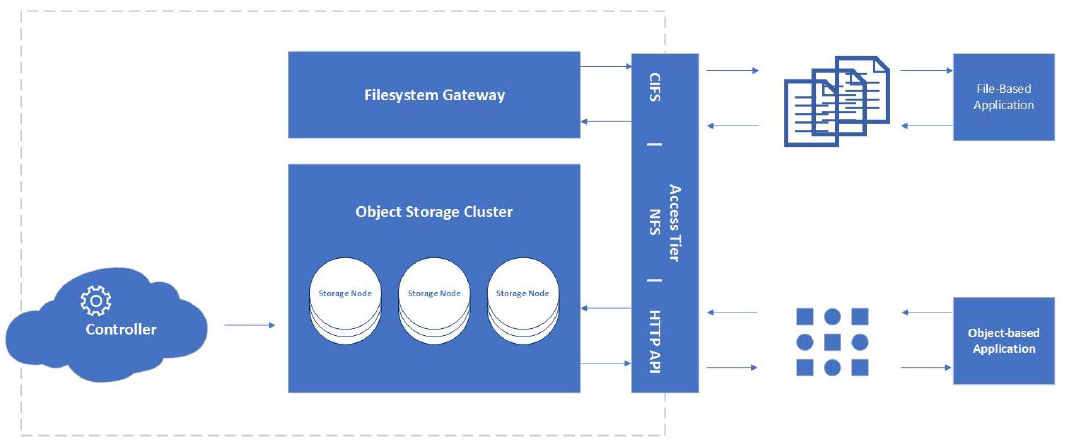
Figure 6. Ingest/Restore Workflow.